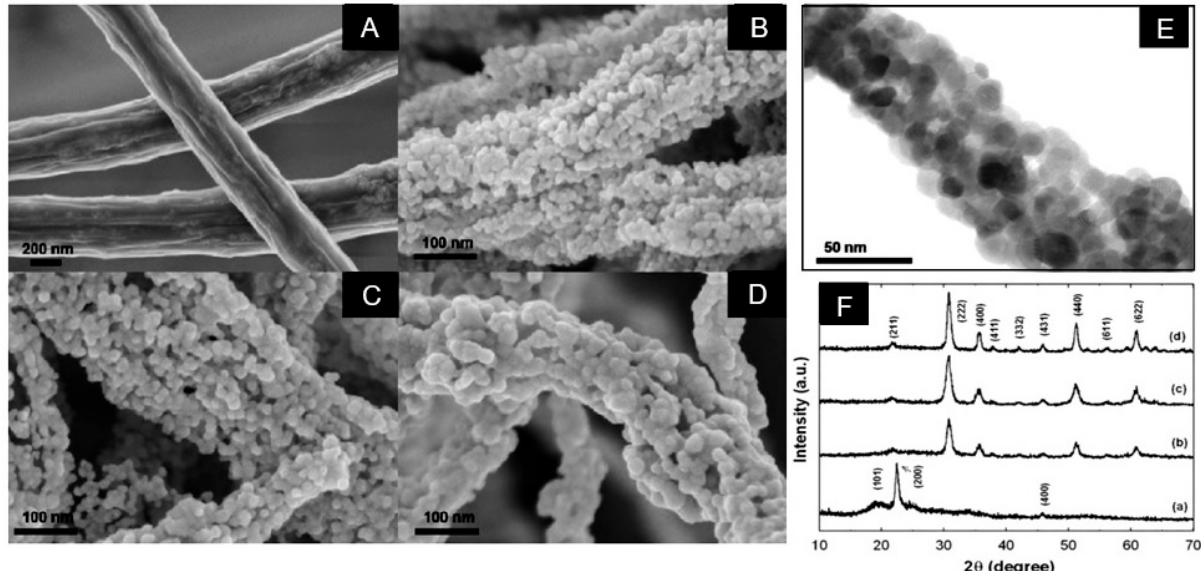
Figure 6. SEM images of ( A ) as prepared PVA/indium acetate composite nanofibers, ( B ) after annealing at T an = 400 °C, ( C ) T an = 500 °C, and ( D ) T an = 600 °C; ( E ) TEM images of In 2 O 3 NF after calcination at T = 500 °C; ( F ) XRD patterns for (a) as prepared PVA/indium acetate composite nanofibers, (b) after annealing at T = 400 °C, (c) T = 500 °C, and (d) T = 600 °C. Reprinted with permission from [91]. Copyright 2010 Elsevier.